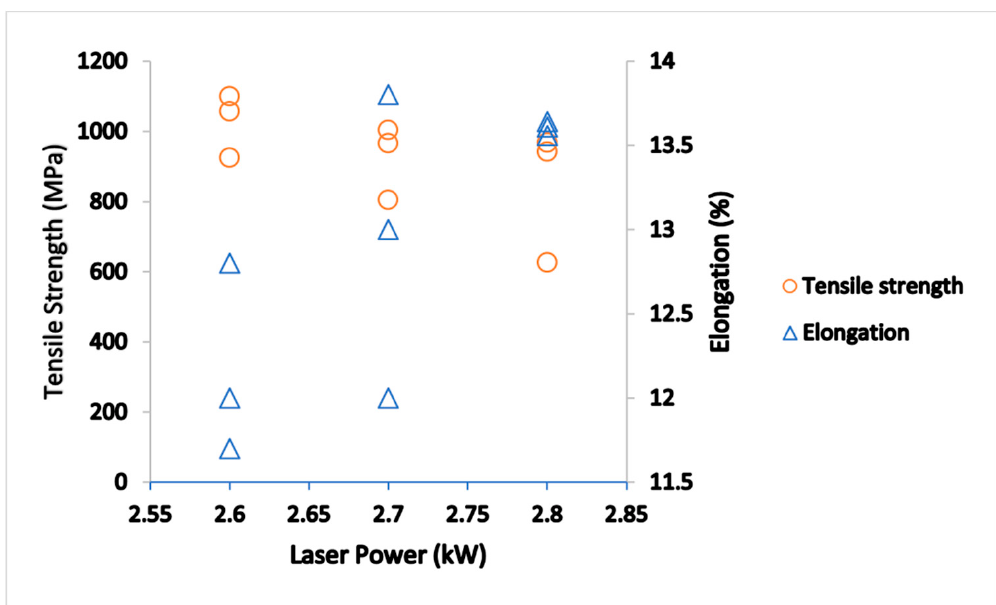
Figure 5. Tensile strength in relation with laser power and elongation of Ti6Al4V. On the other hand, the maximum elongation was observed at a laser power of 2.8 kW and welding speed of 2.6 m/min. The increase in tensile strength at lower power input can be credited to the lower amount of coarse α ’ martensitic microstructure formed within the WZ. Furthermore, Yung et al. [24] suggested that with a faster cooling rate, martensite ages, thereby precipitating fine α particles, resulting in higher